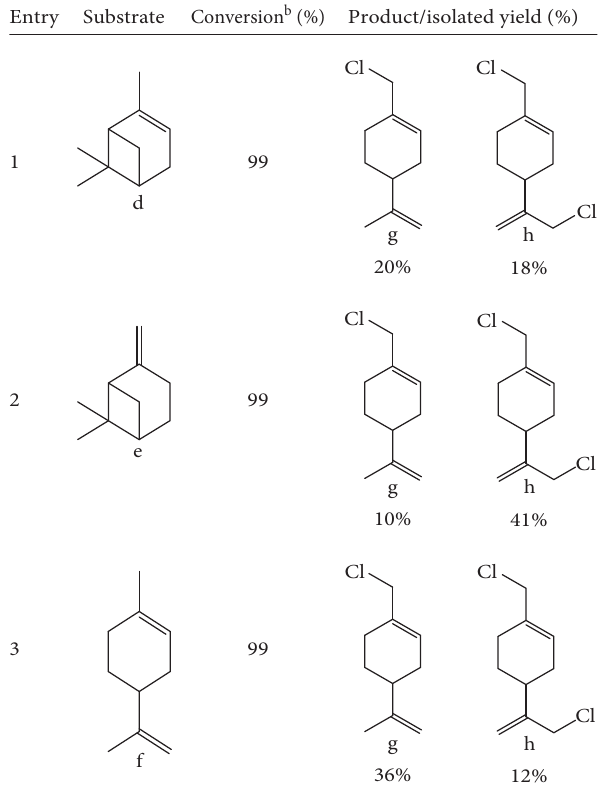
Table 2: Allylic chlorination of nonfunctionalized terpenic olefins a . Entry